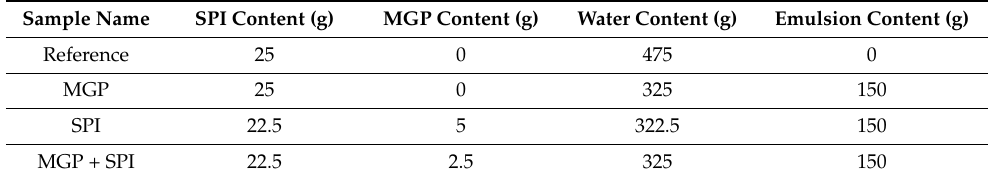
Table 2. Composition of investigated